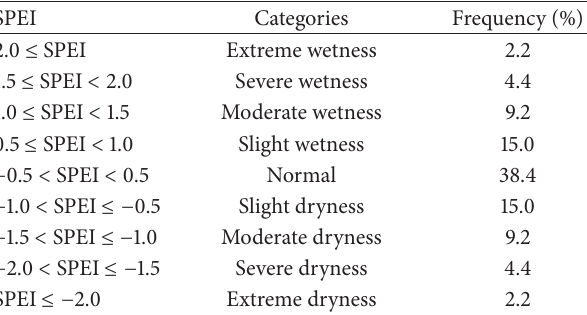
Table 1: Categorization of dryness grade by the